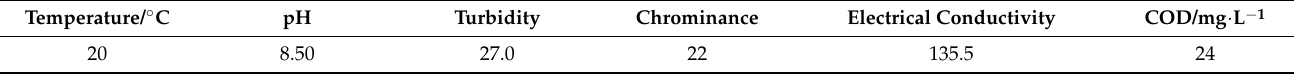
Table 2. Water quality index of lake